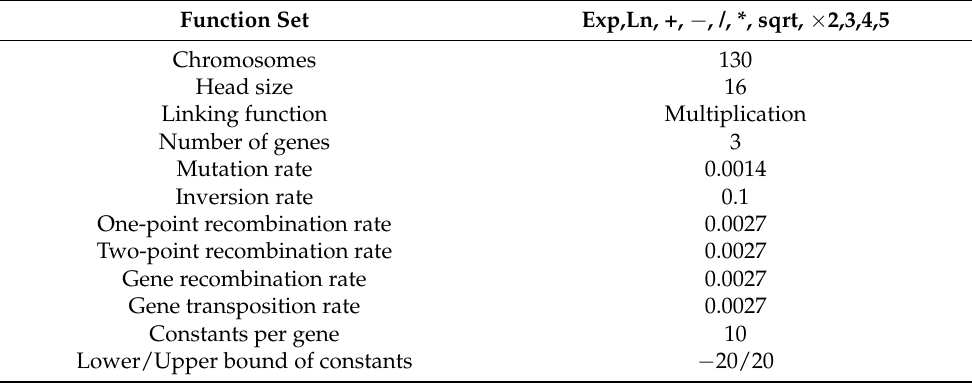
Figure 4. Gene Expression Trees: ( a ) Sub-ET 1, ( b ) Sub-ET 2, ( c ) Sub-ET 3. Table 2. Model Construction